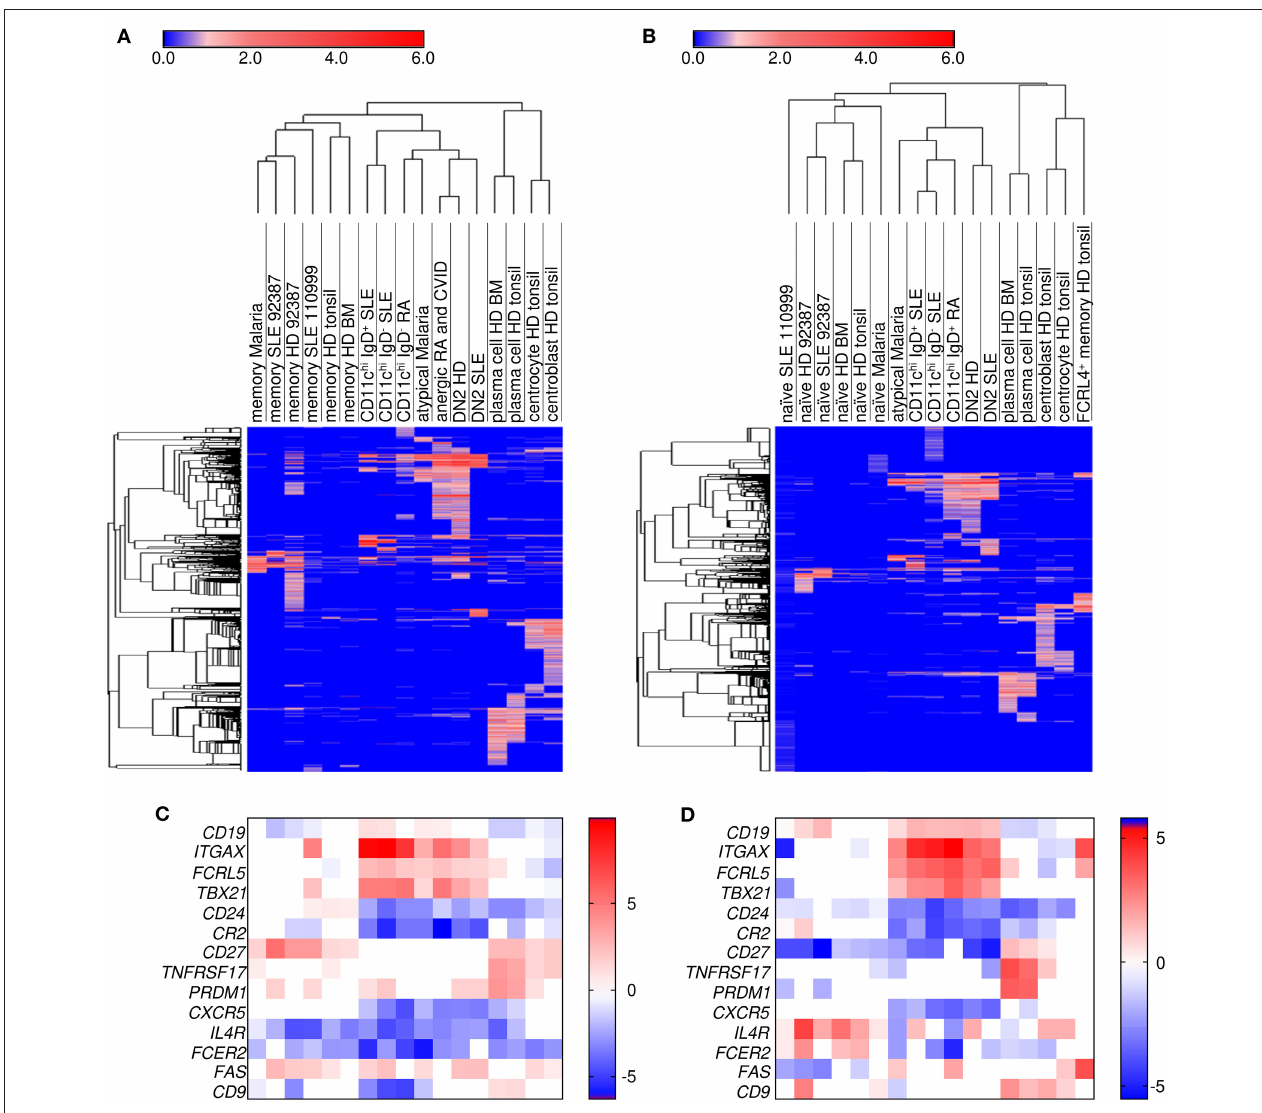
FIGURE 3 | Hierarchical clustering demonstrated that CD11c hi B cells are most similar to DN2, CD21 − CD27 − (atypical), and CD10 − CD21 − CD27 − (anergic) B cells. Limma differential expression analysis was performed between cell populations from multiple datasets to either naïve (A) or memory (B) B cells included in each dataset ( Supplementary Data File 8 ). Transcripts increased in each cell population compared to naïve or memory cells at an FDR < 0.05 were used for row and column hierarchical cluster analysis (one minus Pearson correlation) in Morpheus (https://software.broadinstitute.org/morpheus). The color numerical scale represents the log fold change to naïve (A) or memory (B) . HD, healthy donor; BM, bone marrow. Analysis of a select group of genes which separate the cell populations are shown for naïve (C) or memory (D) B cells. ITGAX , CD11c; TBX21 , T-bet. The order of the cell populations in the heatmaps is the same as the hierarchical clustering maps above each